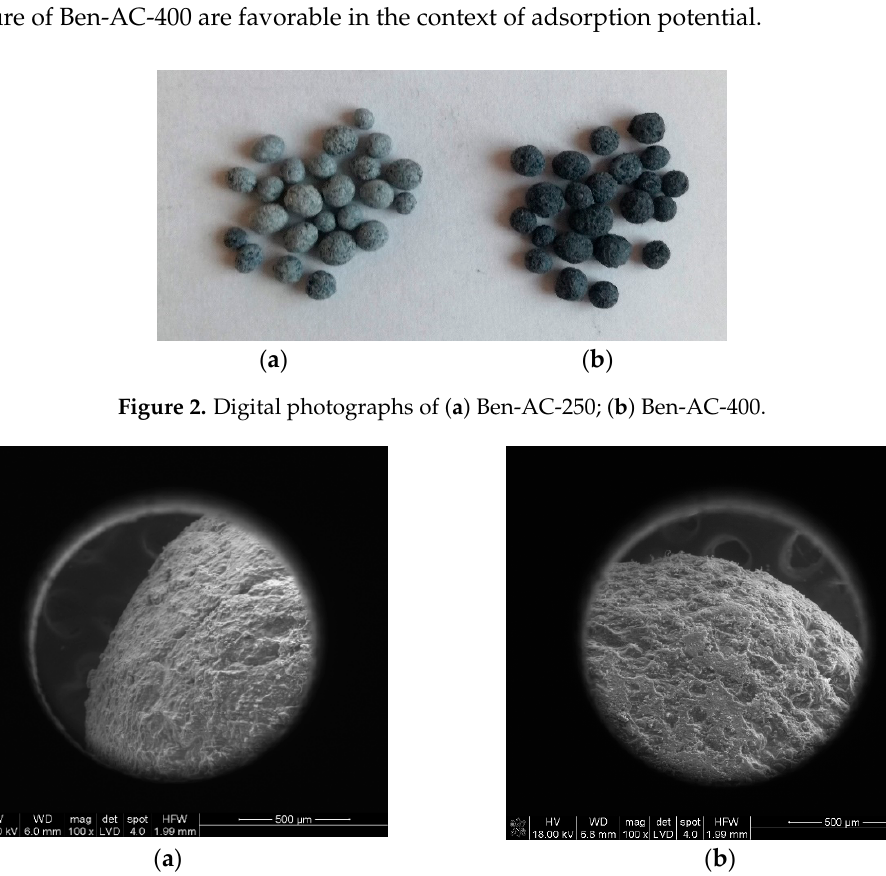
Figure 3. Scanning electron microscope (SEM) surface images of ( a ) Ben-AC-250; ( b ) Ben-AC-400.